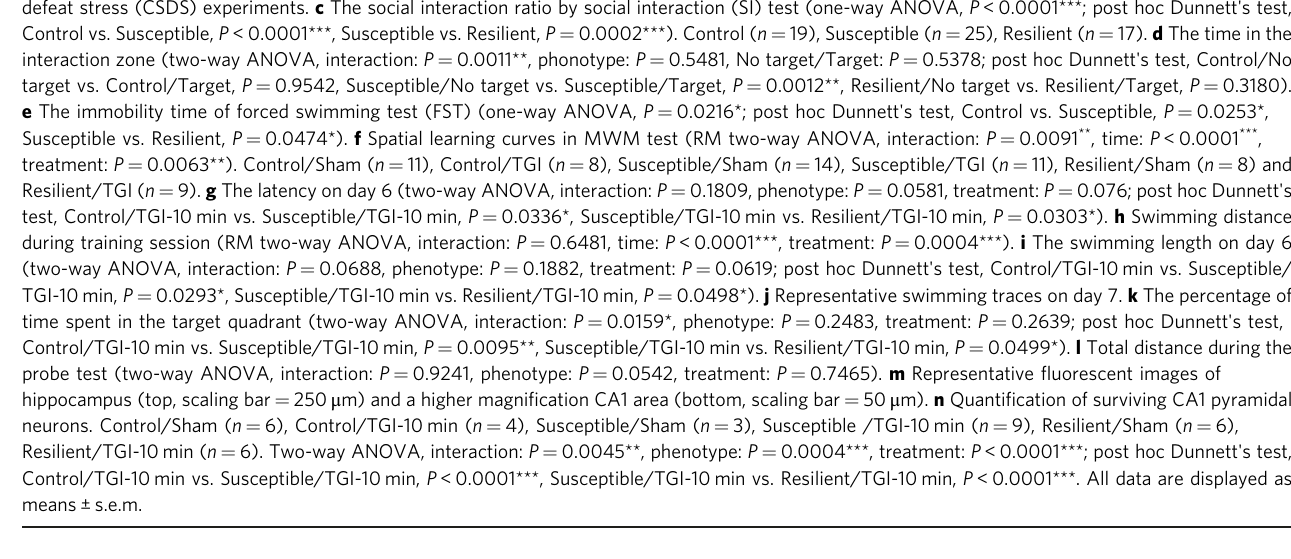
Fig. 2 Chronic social defeat stress aggravates TGI-induced hippocampal injury. a Experimental timeline. b Behavioural paradigm of repeated chronic social defeat stress (CSDS) experiments. c The social interaction ratio by social interaction (SI) test (one-way ANOVA, P < 0.0001***; post hoc Dunnett's test, Control vs. Susceptible, P < 0.0001***, Susceptible vs. Resilient, P = 0.0002***). Control ( n = 19), Susceptible ( n = 25), Resilient ( n = 17). d The time in the interaction zone (two-way ANOVA, interaction: P = 0.0011**, phonotype: P = 0.5481, No target/Target: P = 0.5378; post hoc Dunnett's test, Control/No target vs. Control/Target, P = 0.9542, Susceptible/No target vs. Susceptible/Target, P = 0.0012**, Resilient/No target vs. Resilient/Target, P = 0.3180). e The immobility time of forced swimming test (FST) (one-way ANOVA, P = 0.0216*; post hoc Dunnett's test, Control vs. Susceptible, P =